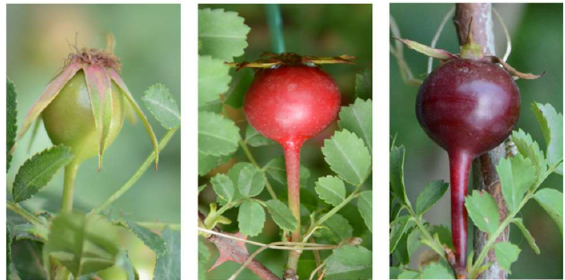
Figure 1. Images of three ripening stages of Rosa xanthina f. spontanea . Table 1. Fruit color parameters of Rosa xanthina f. spontanea hips during ripening. L *